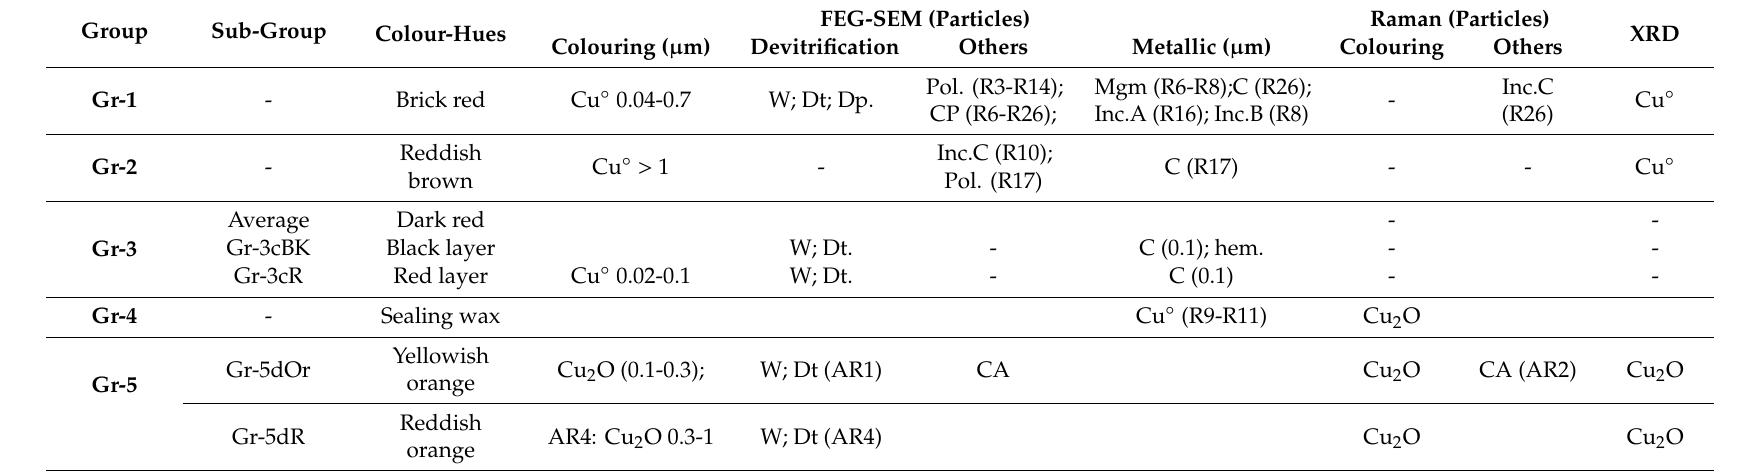
Table 6. Colouring, metallic and devitrification particles investigated by FEG–SEM, Raman spectroscopy and X-ray di ff raction. Cu ◦ : metallic copper; Cu 2 O: cuprite; W: wollastonite (CaSiO 2 ); Dt: Devitrite (Na 2 O · 3CaO · 6SiO 2 ), Dp: diopside (CaO · MgO · 2SiO 2 ). Pol.: polyphase (Al-Si-Na-Fe-Ca); C: Chalcocite (Cu 2 S); CP: